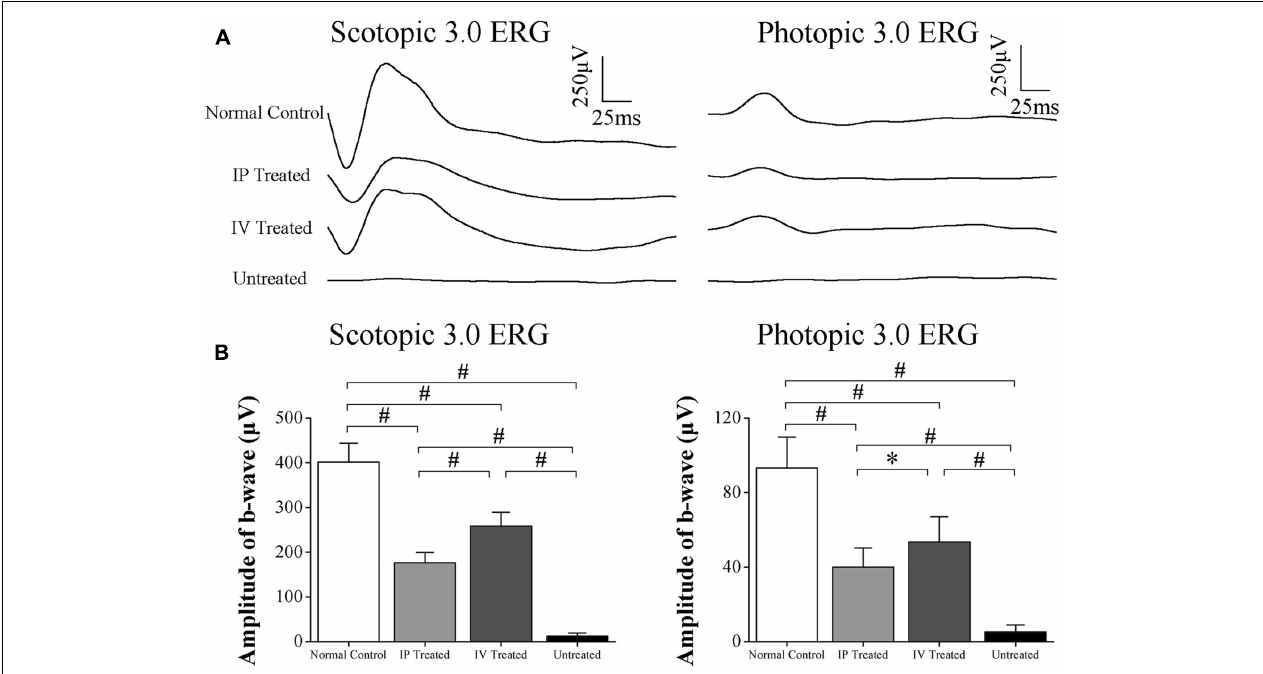
FIGURE 1 | Hydrogen rich saline (HRS) induced effects on the ERGs of MNU administered rats. (A) The representative ERG waveforms of the examined eyes. (B) The amplitudes of both the photopic and scotopic b-waves in the untreated group were substantially smaller than the normal controls ( P < 0.01). The amplitudes of both the photopic and scotopic b-waves in the IV treated group and IP treated group were significantly larger than the untreated group ( P < 0.01). The amplitudes of both photopic and scotopic b-waves in the IV treated group were significantly larger than the IP treated group (photopic : P < 0.01; scotopic: P < 0.05). (All the values were presented as mean ± SD; ∗ P < 0.05, # P < 0.01 for differences compared between the animal